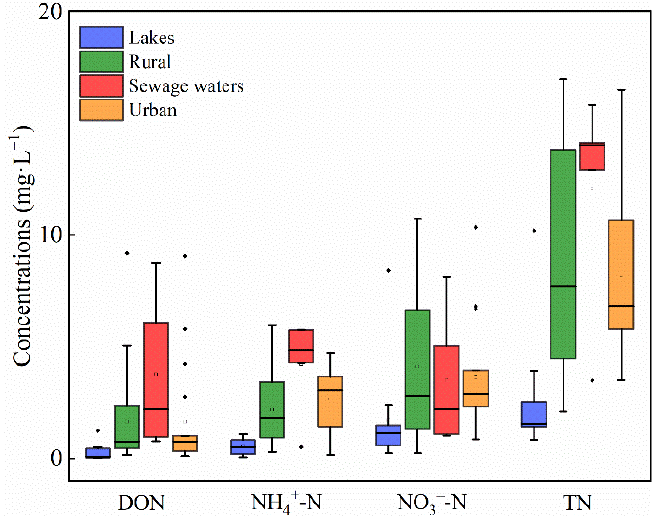
Table 2. Statistics of the nitrogen species in surface water in Tianjin, China.